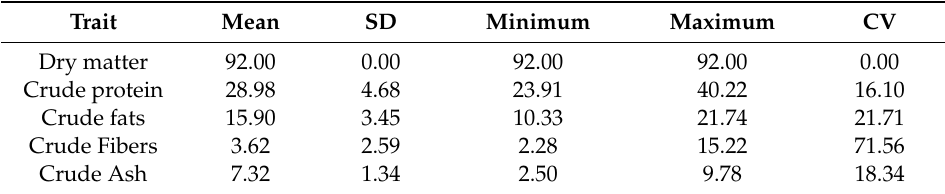
Table 2. Chemical composition (g / 100 g dry matter (DM)) of the commercial dry dog food samples ( n = 81) included in the study reported by the